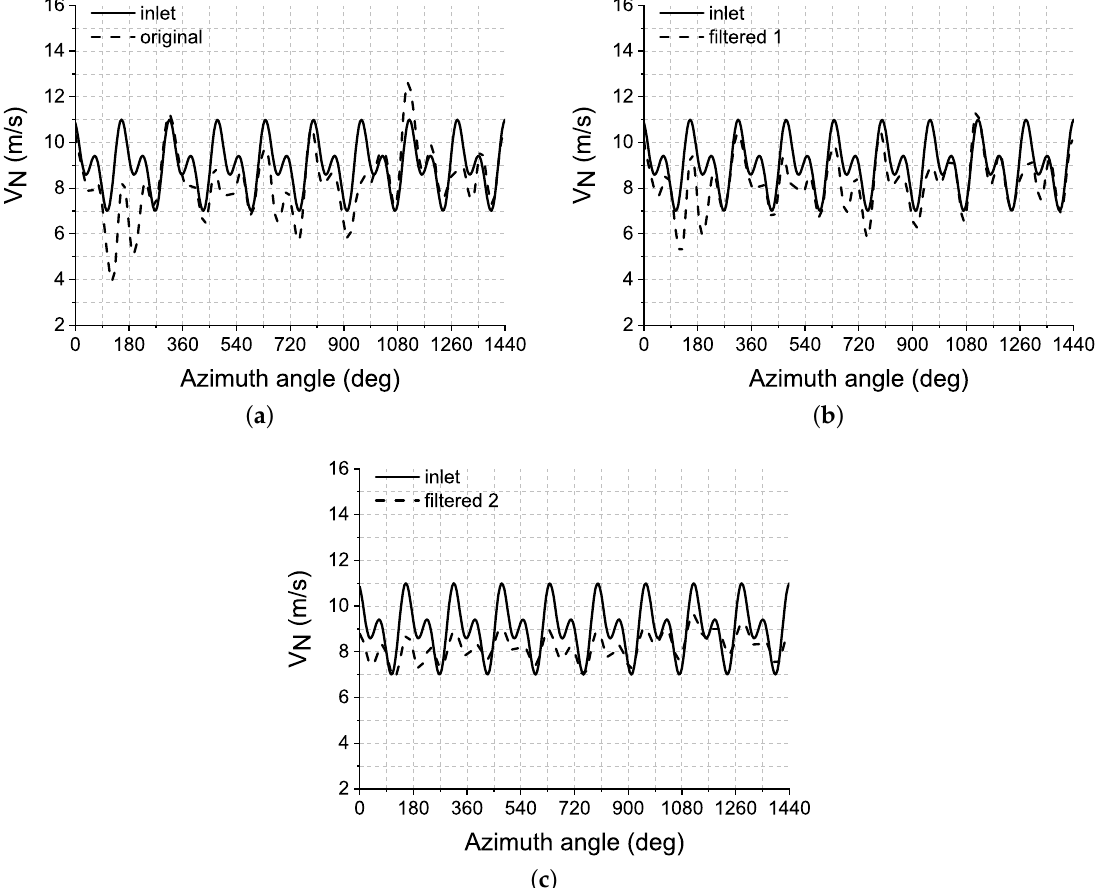
Figure 14. Comparison between inlet wind speed and nacelle wind speed. ( a ) No filtering. ( b ) Blade rotational frequency filtered. ( c ) Blade rotational frequency and high frequencies